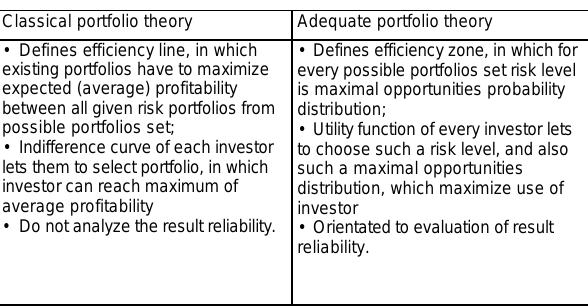
Classical portfolio